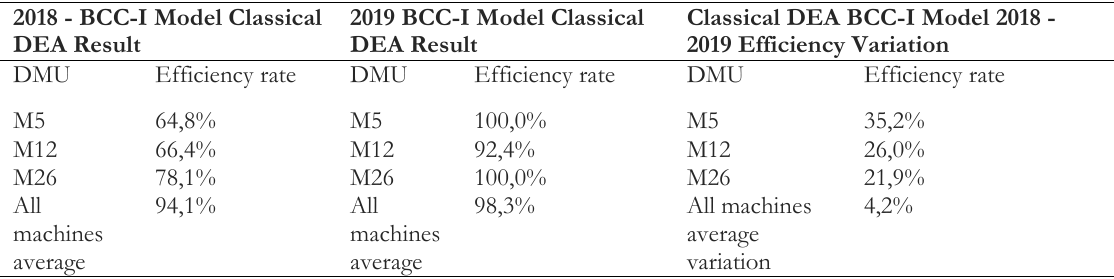
Table 4. CCR – input-oriented classical DEA results and efficiency